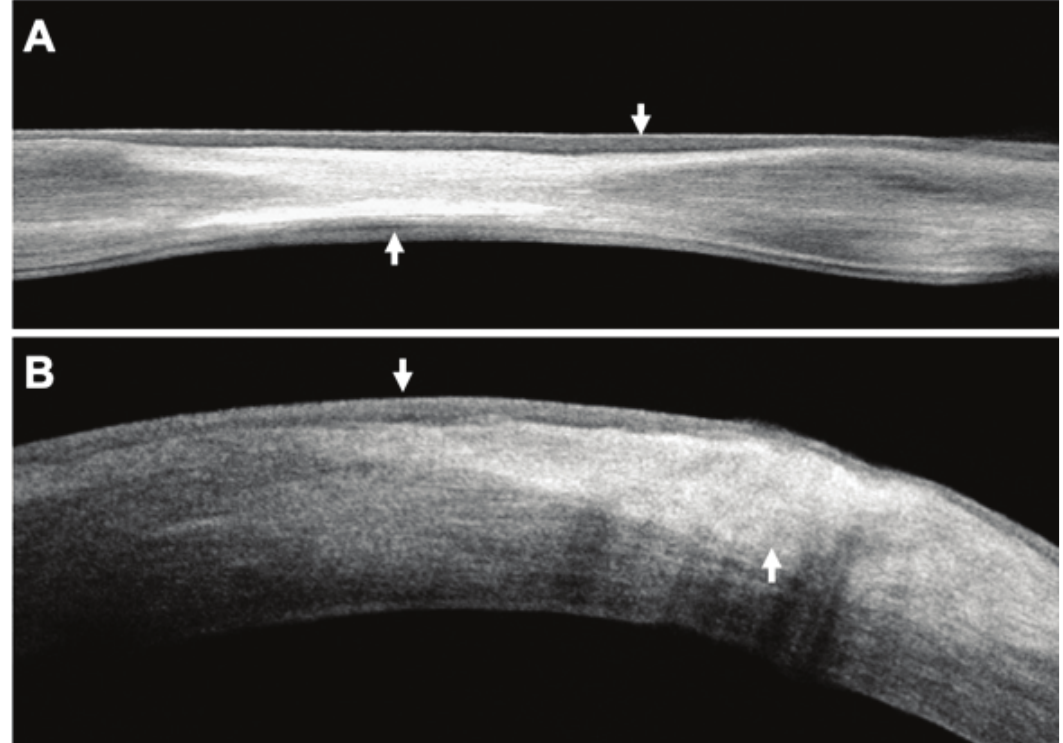
Figure 3. (A) A cross-sectional image of a cornea with inactive HSK showing epithelial remodeling (top arrow) over a zone of stromal fibrosis and compaction (bottom arrow) with the MCT = 441 µm. (B) A cross-sectional image of a cornea with active HSK showing marked stromal edema (CTL = 641 µm) and an active inflammatory infiltrate (bottom arrow) underlying an area of epithelial